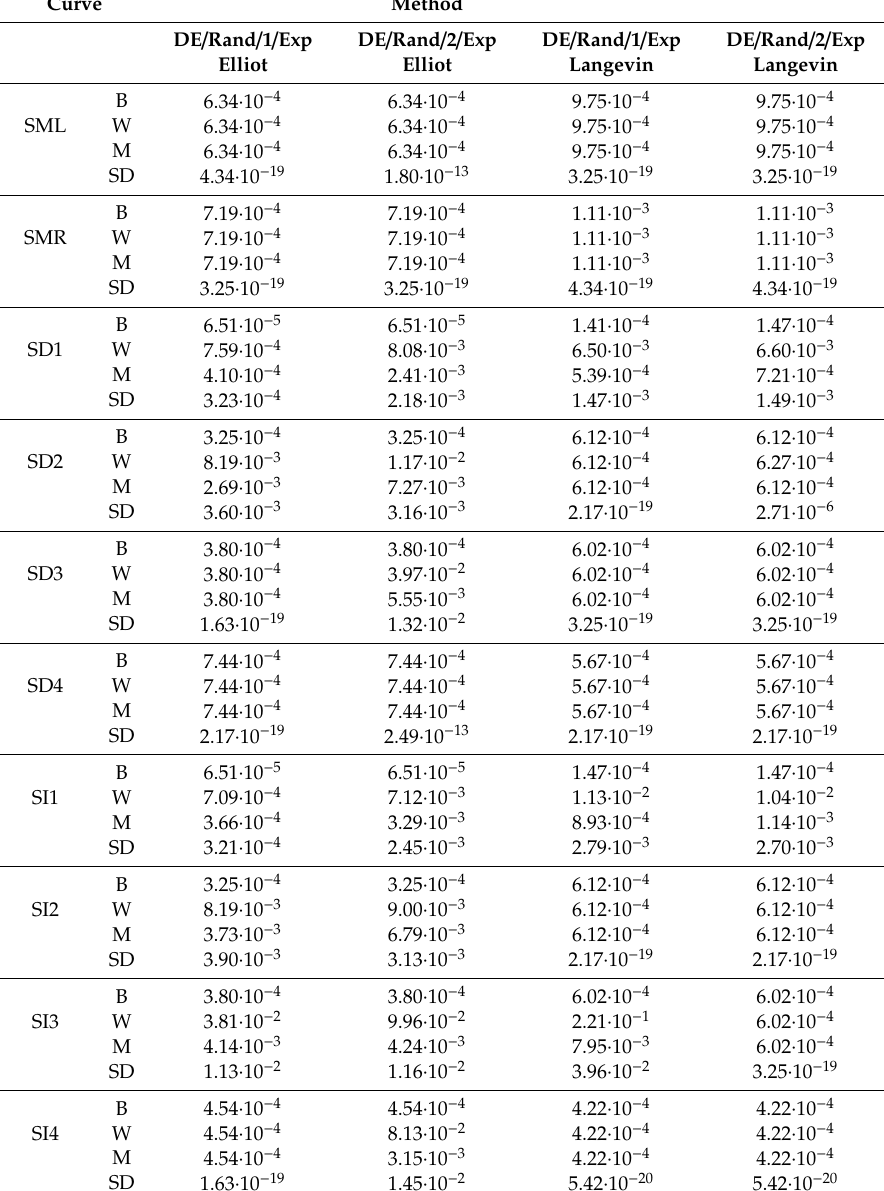
Table 6. B, W, M and SD for 30 independent runs for all 9S20 curves using DE / rand / 1 / exp and DE / rand / 2 / exp for the Elliot and Langevin expressions.